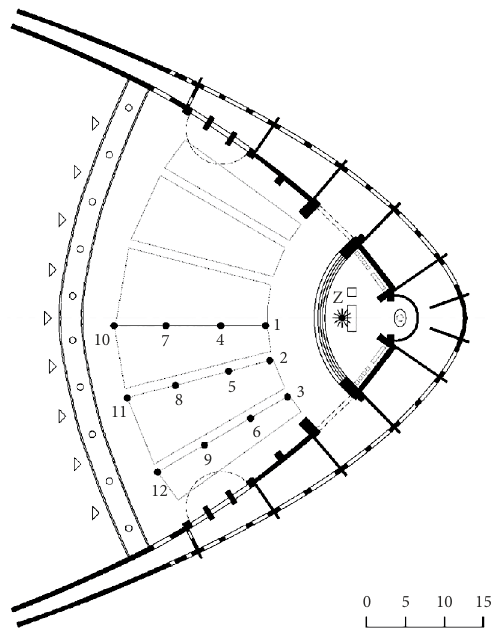
Figure 3. View of the church with marked measuring points